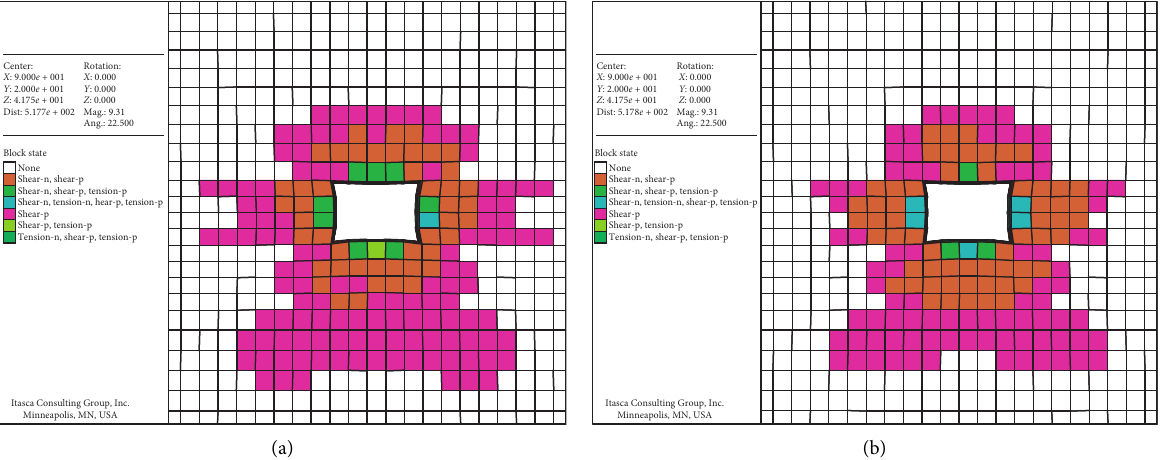
Figure 19: Cloud diagram of the plastic zone. (a) No support; (b)